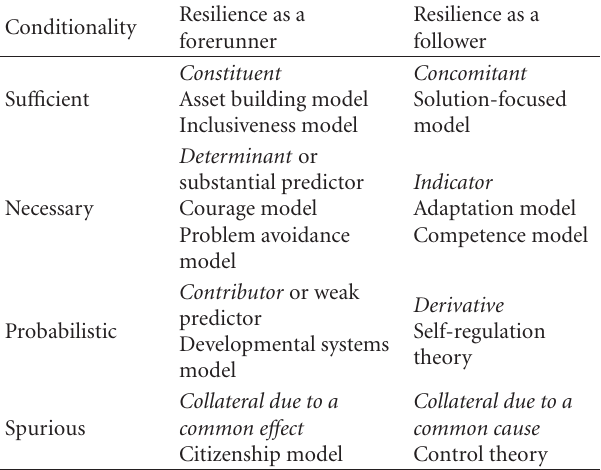
Table 1: Models relating resilience and positive youth